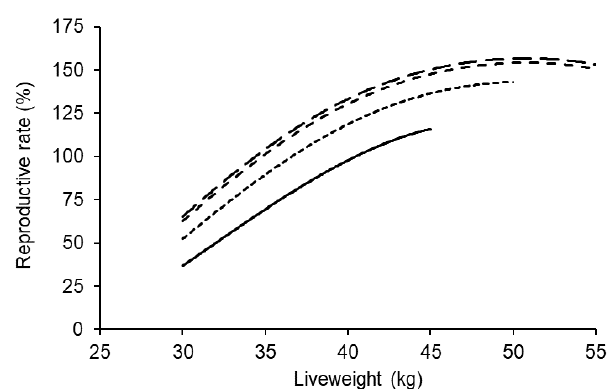
Figure 3. The effect of liveweight at the start of breeding on reproductive rate for ewe lambs that were 6 (bottom), 7, 8 or 9 (top) months of age. The data represent over 11,500 maternal composite ewe lambs and the average across the ewe lambs own birth type. The average 95% confidence interval across all scenarios was ±10.0%.